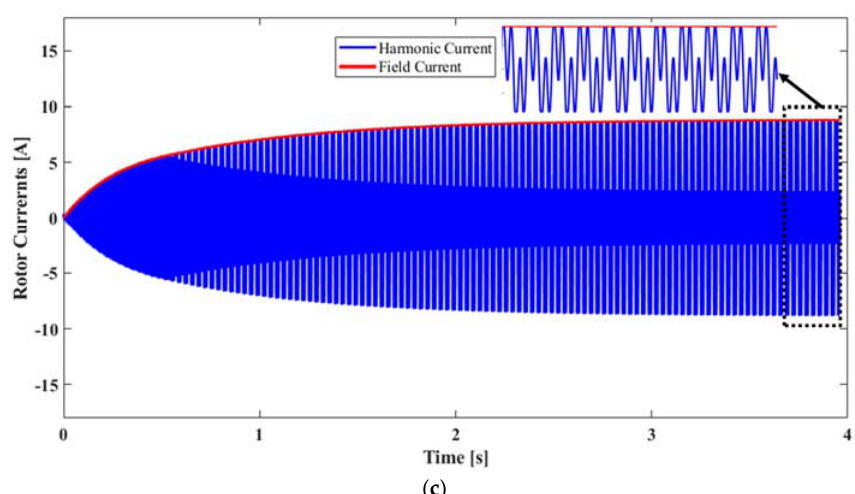
Figure 10. Rotor currents of ( a ) reference machine, ( b ) proposed machine case 1, ( c ) proposed machine case 2.